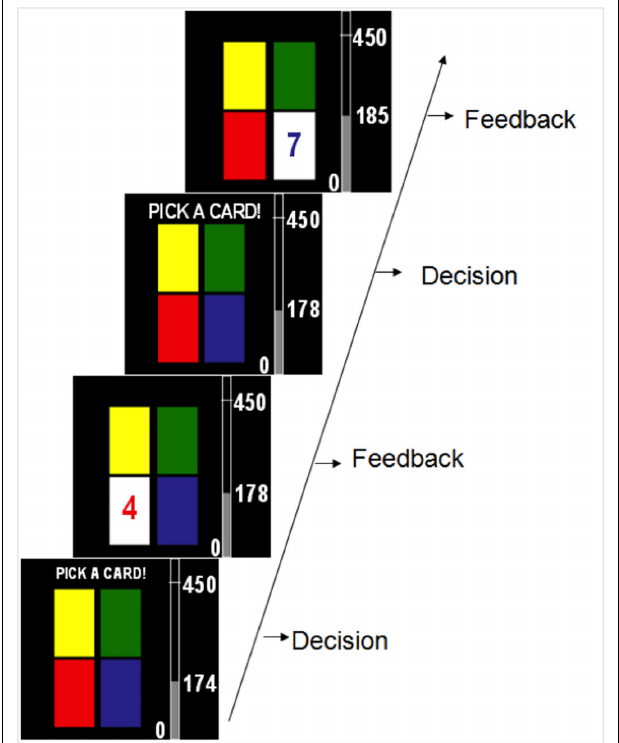
FIGURE 1 |Timeline of two possible trials in the experiment. On each trial participants received between 1 and 10 points after selecting each